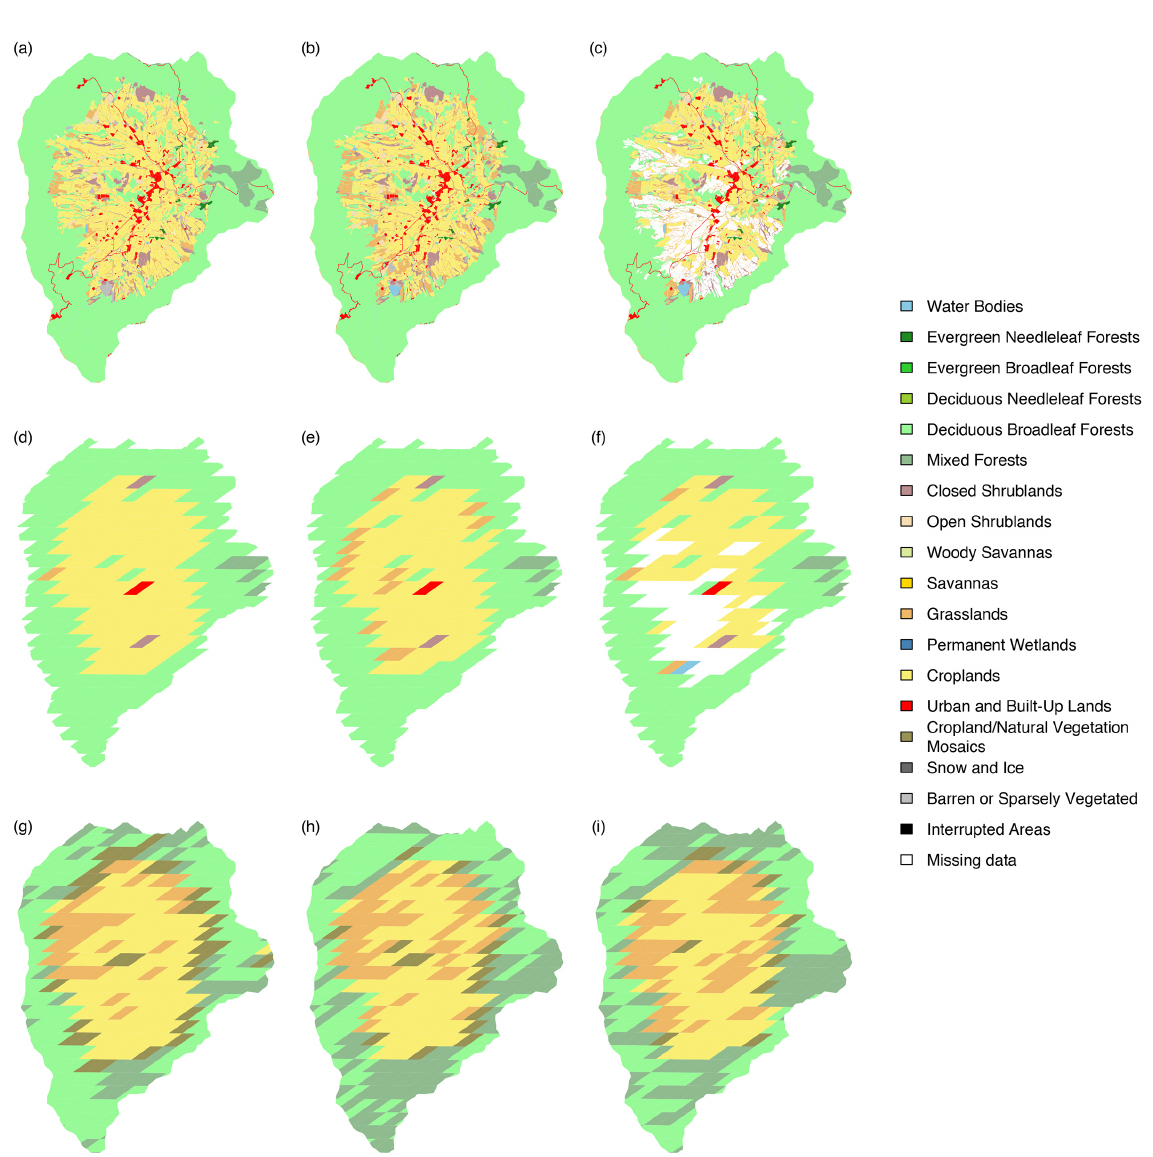
Figure 7. Land use and land cover reclassified according to the IGBP 17-class system: the original survey data in (a) 2009, (b) 2010 and (c) 2011; the rasterised survey data in (d) 2009, (e) 2010 and (f) 2011; MODIS Land Cover Type product (MCD12Q1) in (g) 2009, (h) 2010 and (i) 2011. Note that the IGBP system does not distinguish the paddy field from a general cultivated zone. Note that “interrupted areas” is a special mask for Goode’s interrupted area (US Geological Survey,